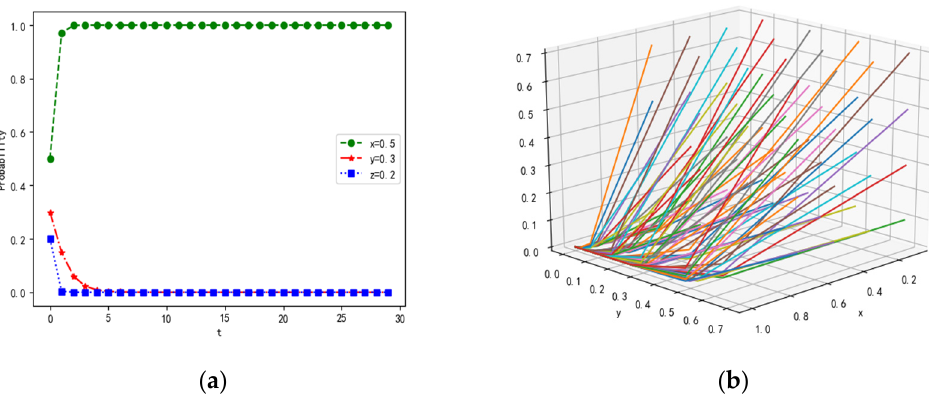
Figure 4. Evolutionary results of p 3 ( 1,0,0 ) shown under a corresponding constraint condition, ( a ) represents the conver- gence of probability with time, and ( b ) shows the results of dynamic simulation in three dimensions.